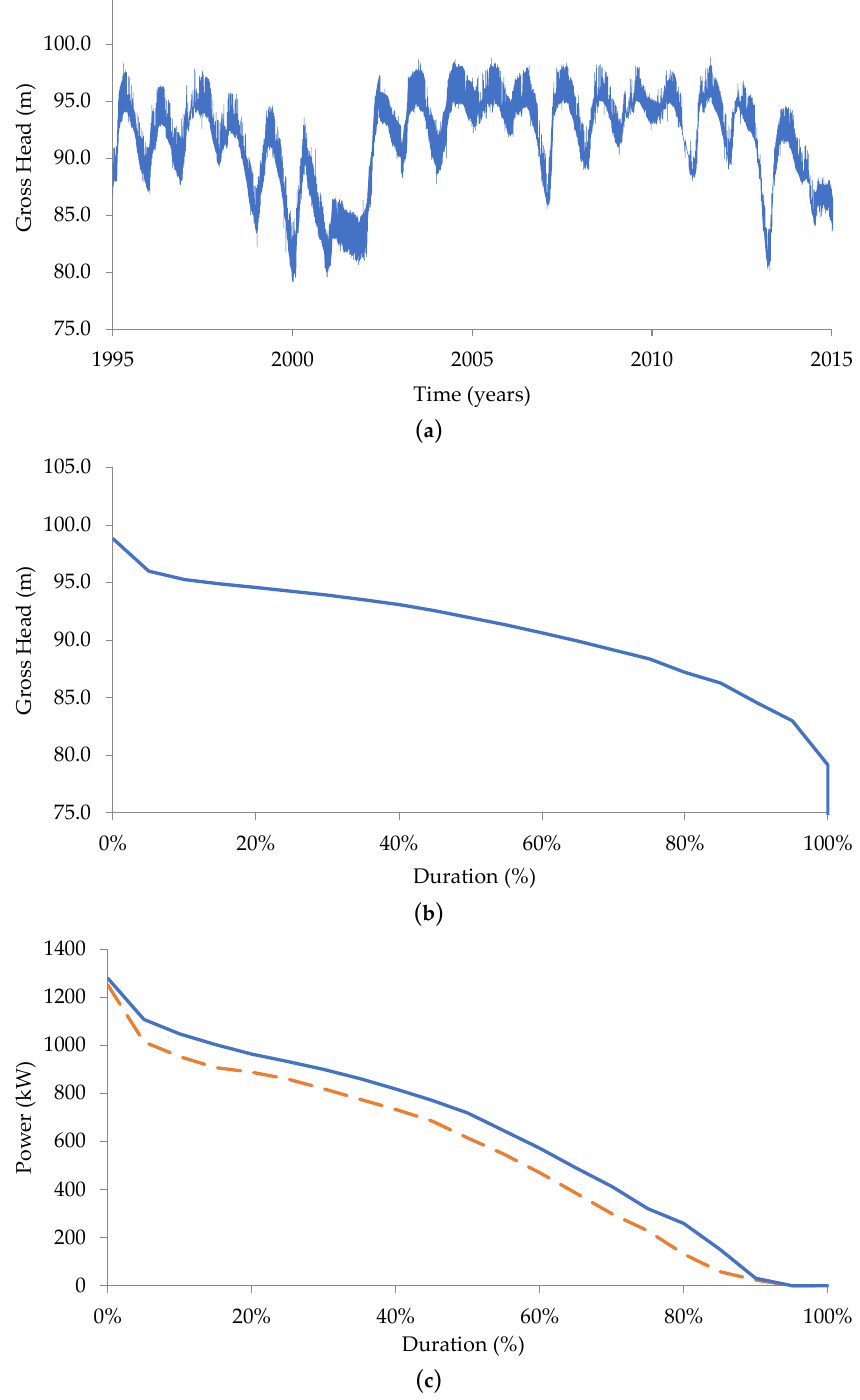
Figure 15. Operation characteristics of the Furnas hydro power plant. Gross head variation over the years ( a ), gross head duration curve ( b ), and generated power duration curve ( c ).